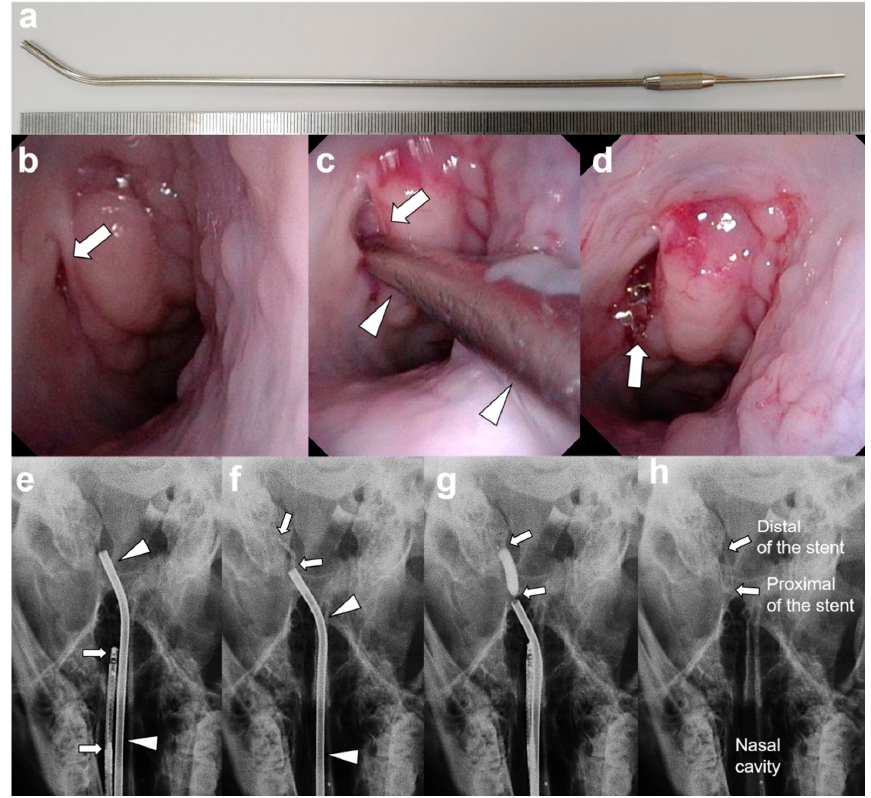
Figure 1. ( a ) Photograph showing the metallic guiding sheath developed for the porcine Eustachian tube (ET) model. ( b – h ) The technical steps of stent placement in a porcine ET. ( b ) Baseline endoscopic image showing the nasopharyngeal orifice (arrow) of the right ET. ( c ) Endoscopic image showing the location of the metallic guiding sheath (arrowheads) at the ET orifice. ( d ) The proximal end of the stent (arrow) protrudes from the nasopharyngeal orifice of the ET. ( e ) Radiograph obtained during stent placement showing the metallic guiding sheath (arrowheads) and flexible endoscopy (arrows). ( f ) A balloon catheter with a crimped stent (arrows) was inserted through the sheath (arrowheads) into the ET. ( g ) The balloon catheter (arrows) was fully inflated. ( h ) Radiograph obtained immediately after stent placement showing a fully expanded stent